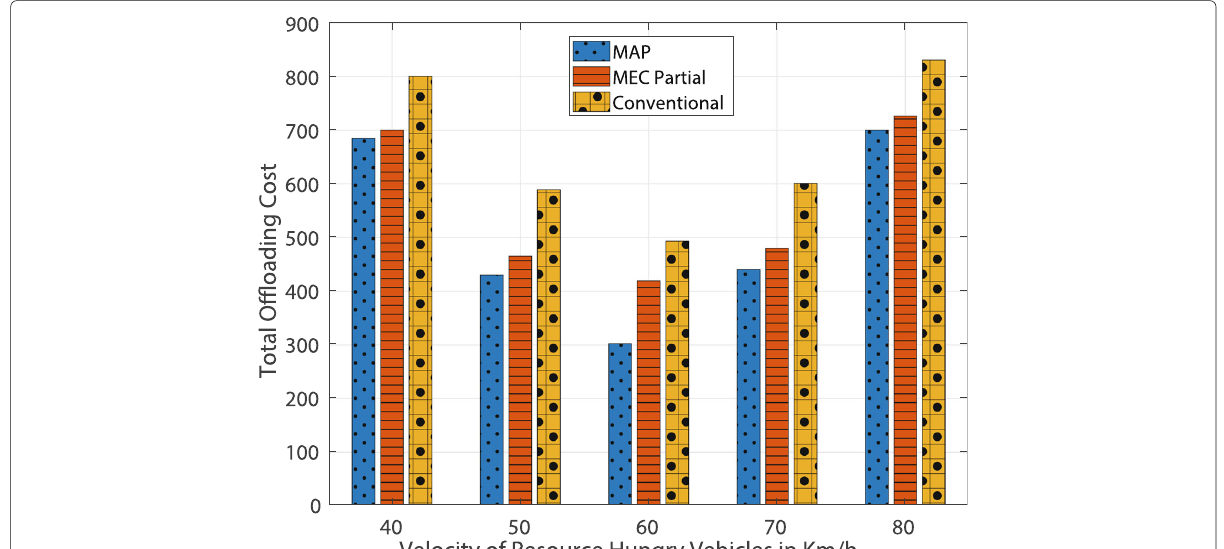
Fig. 7 The total offloading cost versus varying RHVs velocity, when velocity of the